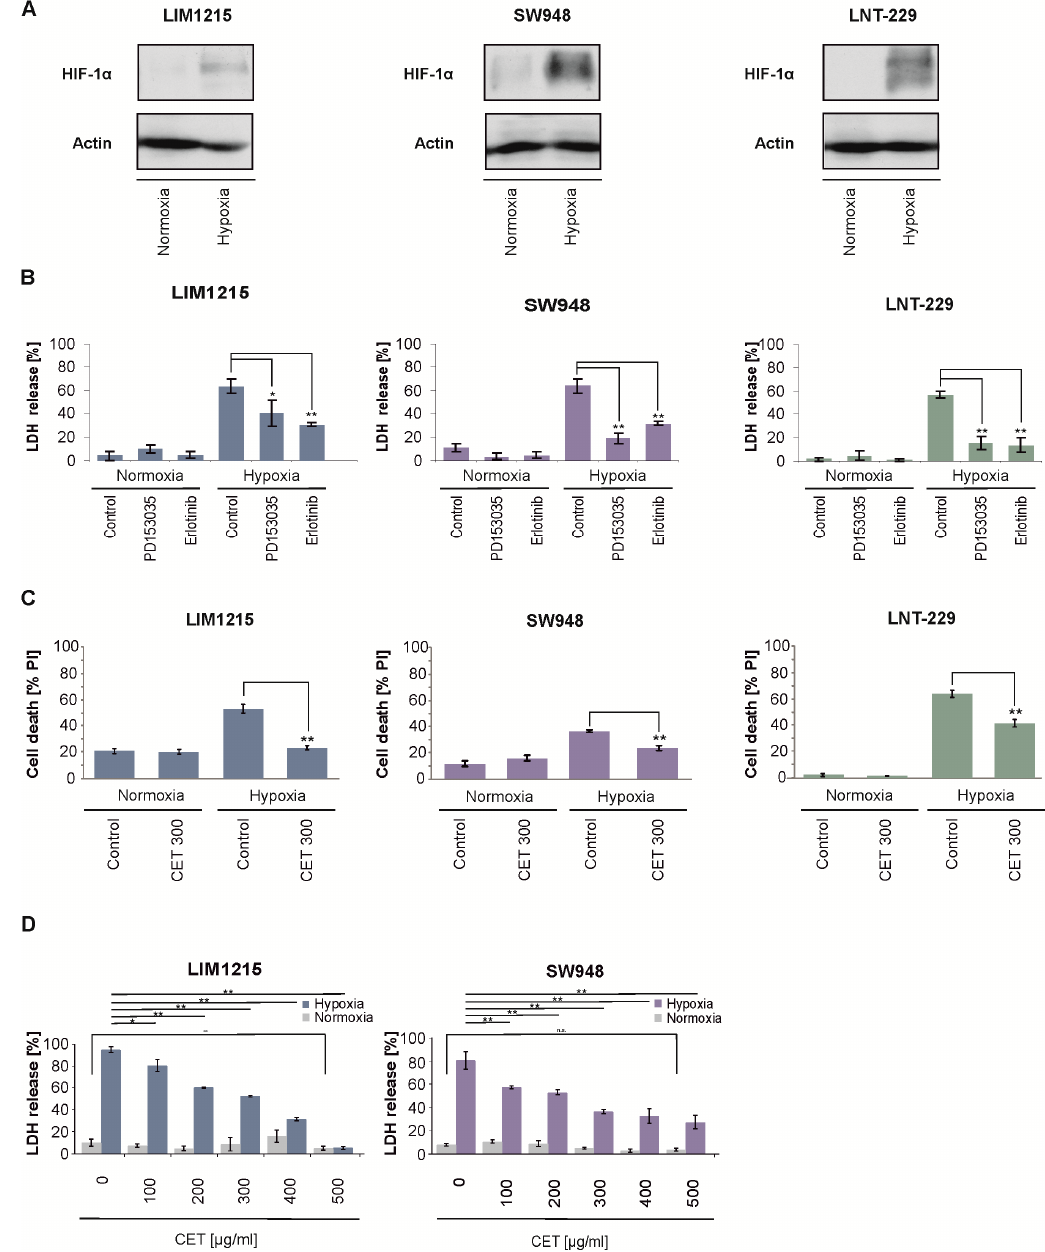
Figure 2. EGFR inhibition protects colon carcinoma and glioma cells from hypoxia-induced cell death. LIM1215, SW948, and LNT-229 cells were incubated in serum-free medium containing 2 mM glucose under normoxic or hypoxic conditions. ( A ) Induction of hypoxia-inducible factor HIF-1 α in hypoxia was verified by immunoblot, the uncropped immunoblot figure in Figure S7. ( B ) Cells were treated with 10 µM erlotinib, 10 µM PD153035, and vehicle, respectively. Cytotoxicity was estimated by LDH release ( n = 4, mean ± SD, * p < 0.05, ** p < 0.01). ( C ) Cells were incubated with vehicle or 300 µ g / mL cetuximab (CET 300). Cell death was quantified by PI uptake ( n = 3, mean ± SD, ** p < 0.01). ( D ) LIM1215 and SW948 cells were treated with vehicle or cetuximab (CET) at concentrations ranging from 100 to 500 µ g / mL. Cell death was quantified by LDH release ( n = 4, mean ± SD, ** p < 0.01, n.s., not